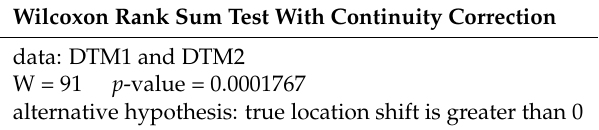
Table 6. Mann–Whitney U non-parametric statistical test applied to the development times